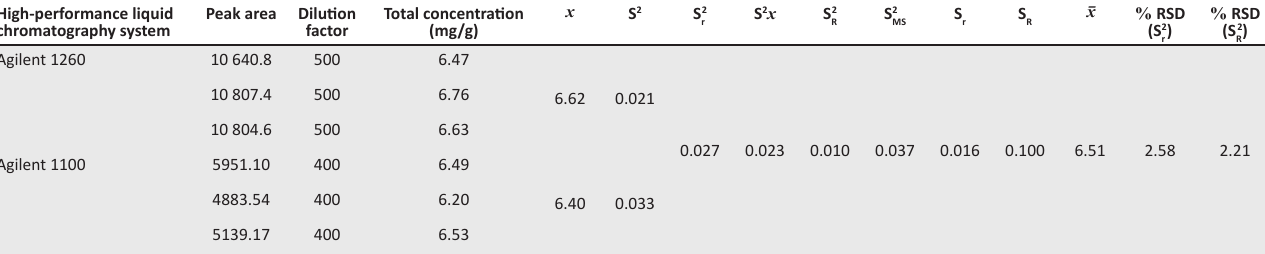
TABLE 5: Determination of repeatability and reproducibility. High-performance liquid chromatography